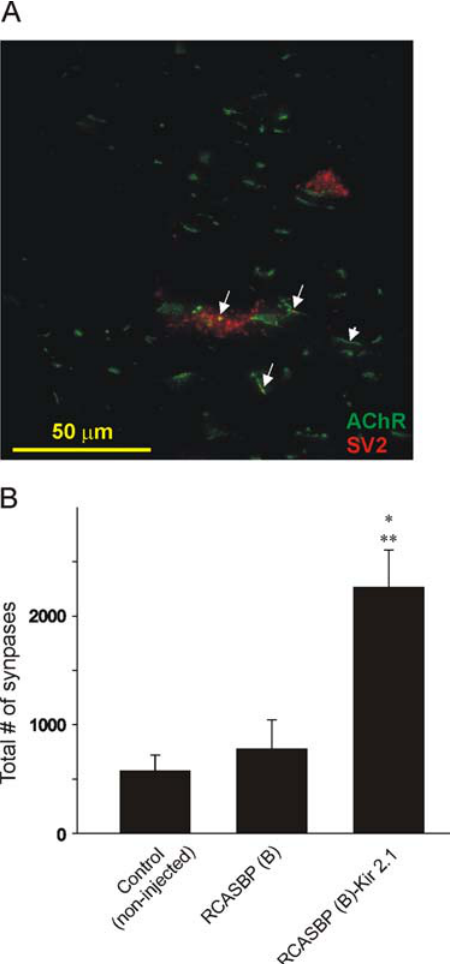
Figure 8. A) Distribution of AChR clusters and presynaptic terminals in a cross section of the iliofibularis (IFIB) muscle as revealed by double labeling with Alexa 488- conjugated a - bungarotoxin and SV2. Large arrows indicate co-localization of AChR clusters and presynaptic terminals, whereas the short arrow indicates an AChR clusters alone. B) The total number of synapses (as determined by co-localization of AChR clusters and SV2-labeling) was determined in control (non-injected), or chicken embryos infected with RCASBP(B) open vector or RCASBP(B)-Kir2.1. Chicken embryos were isolated at E7. Notice there are no significant differences in the number of synapses between non injected and RCASBP(B)-infected embryos. Infection of chicken embryos with RCASBP(B)-Kir2.1 results in a significant increase in the number of synapses along the IFIB muscle at E7. * denotes p # 0.05 vs. control (non-injected); ** denotes p # 0.05 vs. RCASBP(B)-infected embryos (n=3).